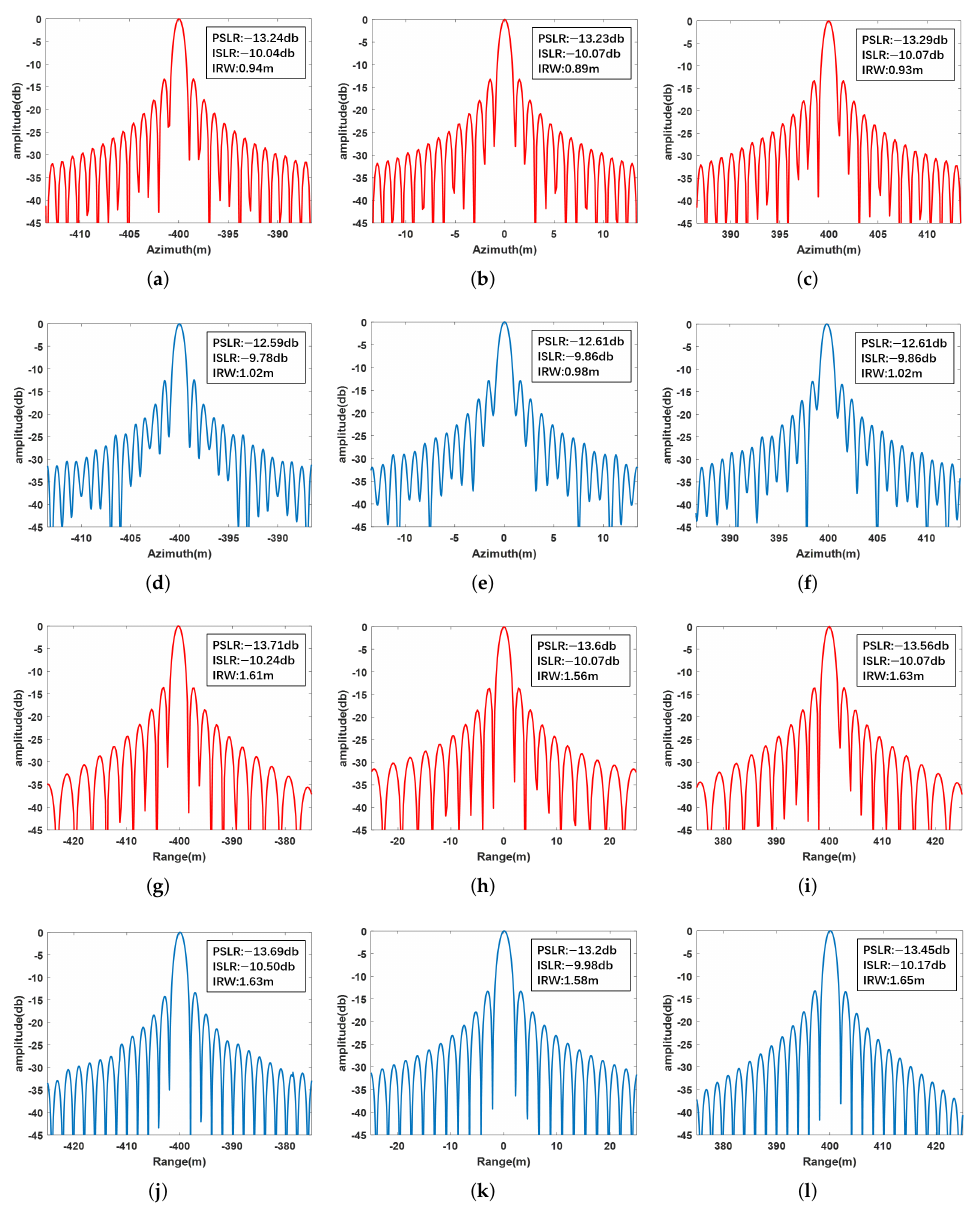
Figure 10. Detailed imaging results by WFBP and FBP algorithm. ( a ) Azimuth slice of Target P1